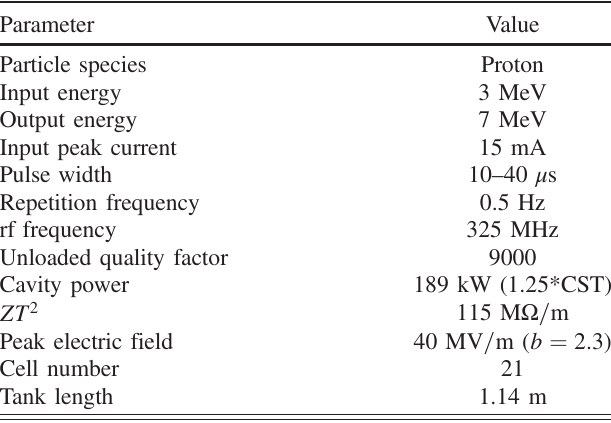
TABLE I. Main design parameters of the